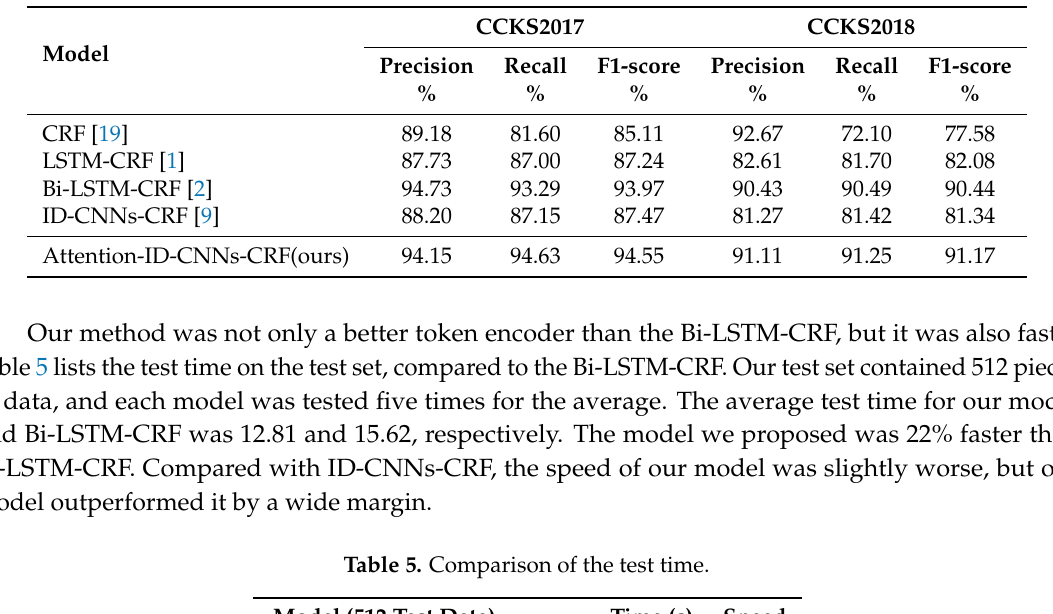
Table 4. Results of different NER models on the CCKS2017 and CCKS2018 datasets.